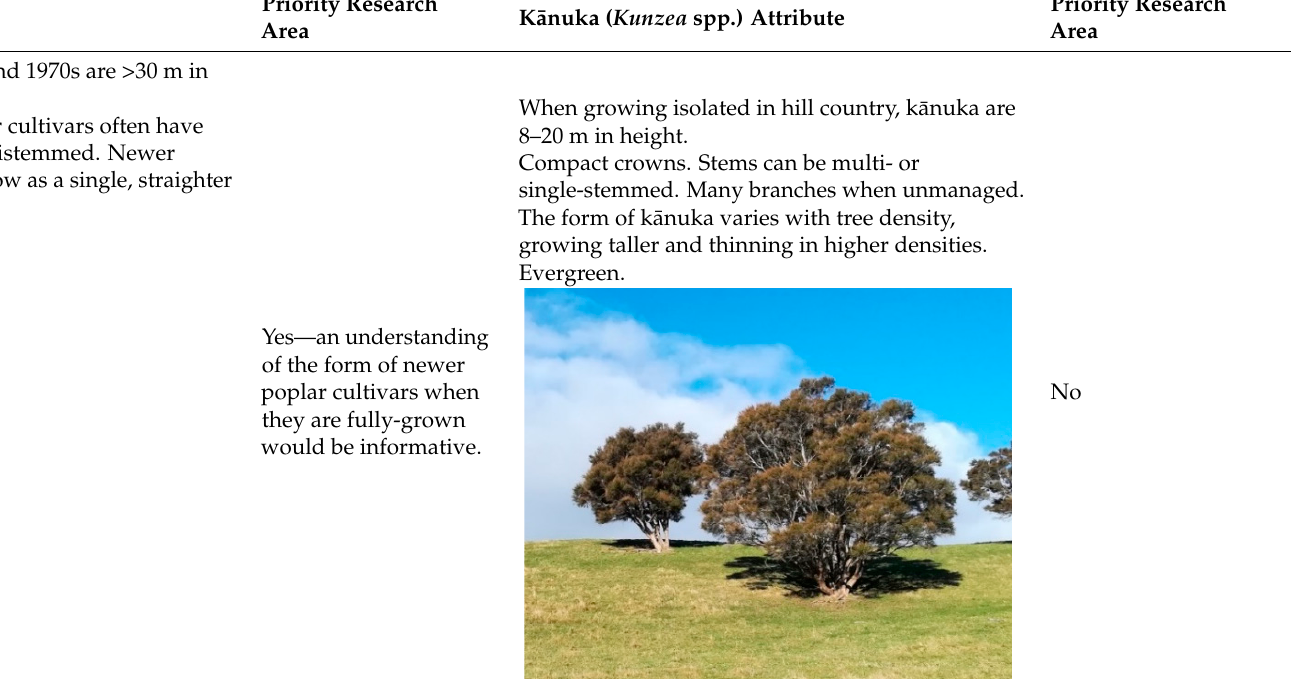
Table 2. Tree attributes for poplar ( Populus spp.) and k ā nuka ( Kunzea spp.) in a New Zealand hill country silvopastoral system. Tree attributes have been adapted from Wood [15]. The photographs were taken by the lead author. Tree Attribute